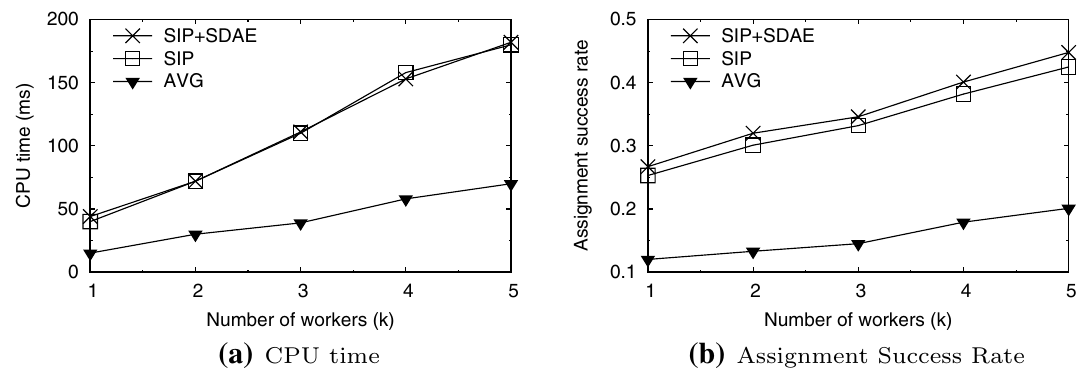
Fig. 8 Performance of preference modeling: effect of | W |